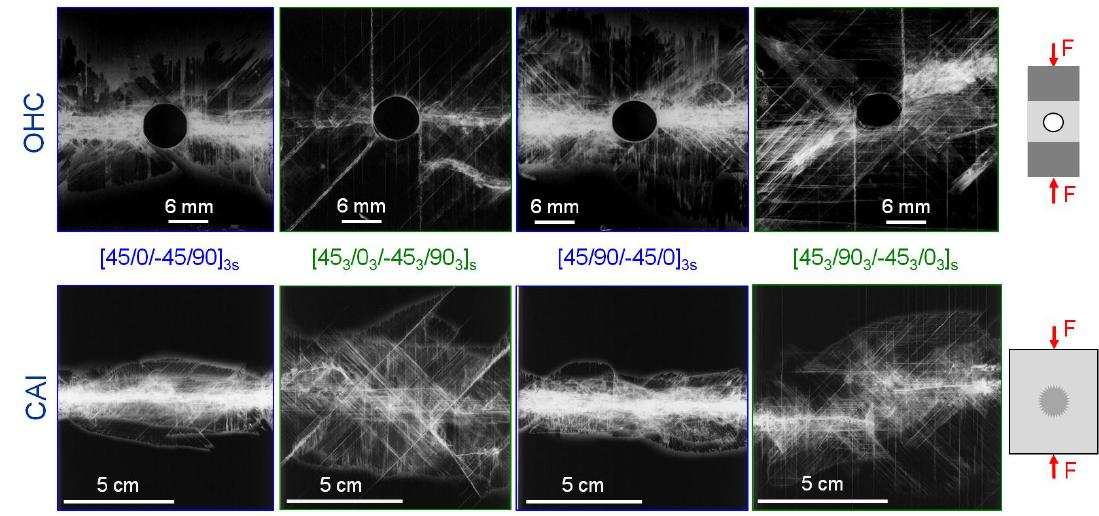
Figure 6. X-ray images of final failure for representative OHC ( top row) and CAI ( bottom row) specimens (Material: HexPly-M21/34%/UD194/T800S).